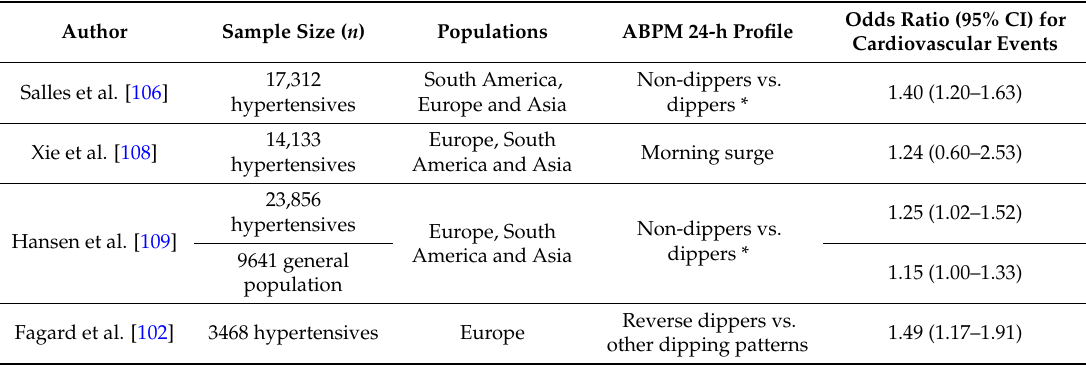
Table 2. Meta-analyses of circadian pattern abnormalities and cardiovascular